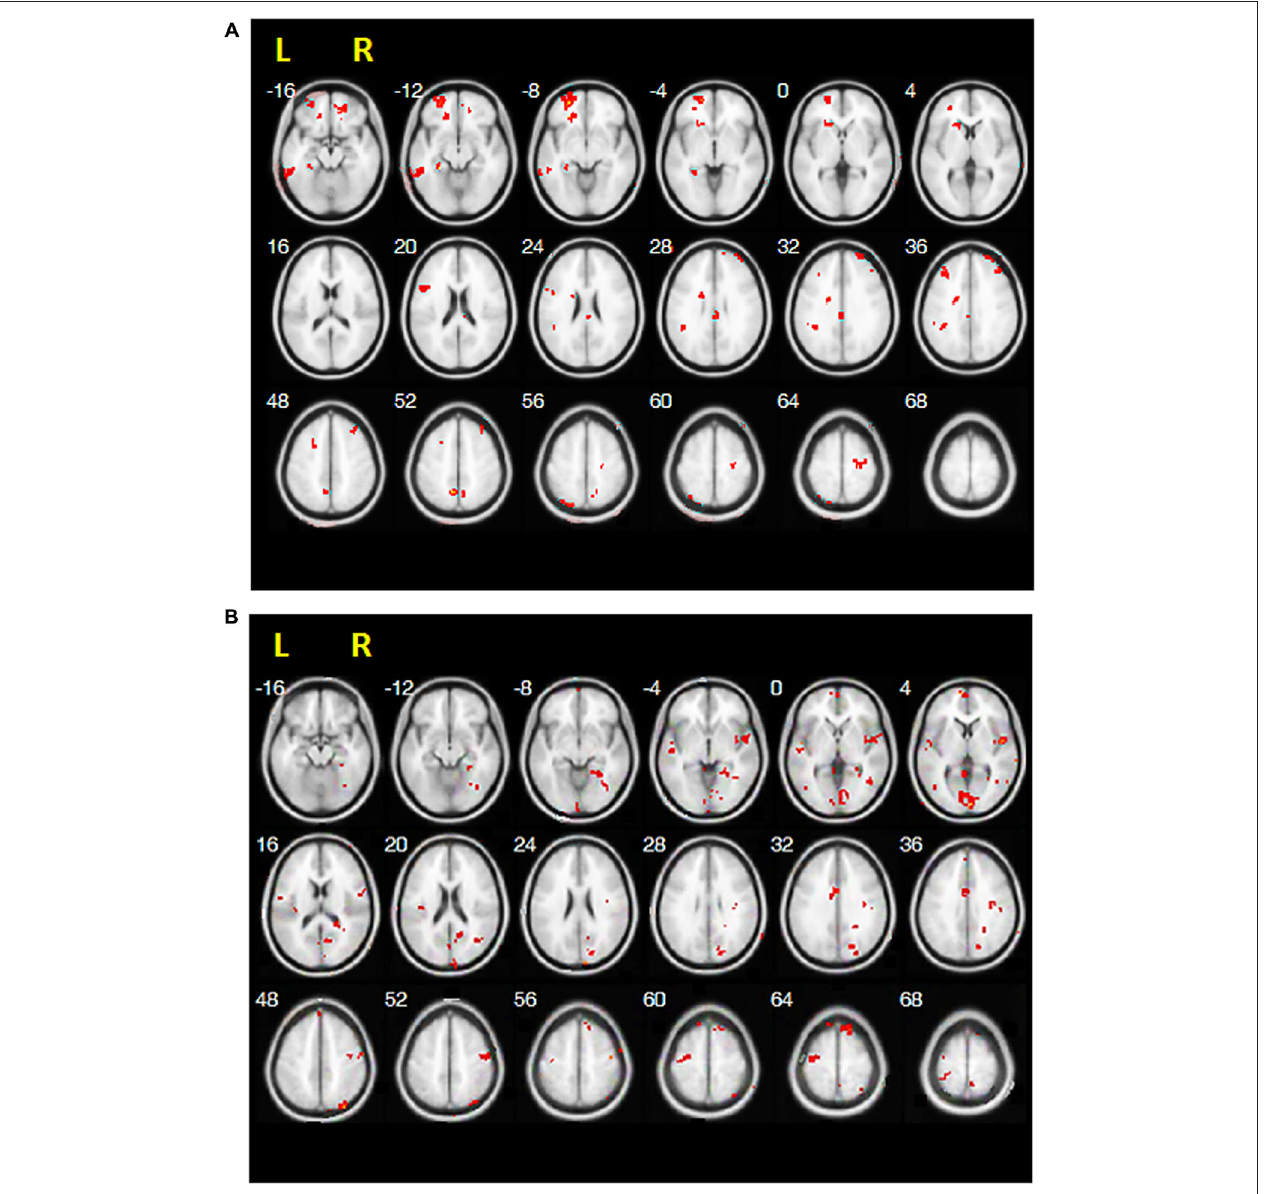
FIGURE 2 | Resting-state functional connectivity results of paired t -tests between (A) pre-treatment vs. post-treatment and (B) post-treatment vs.